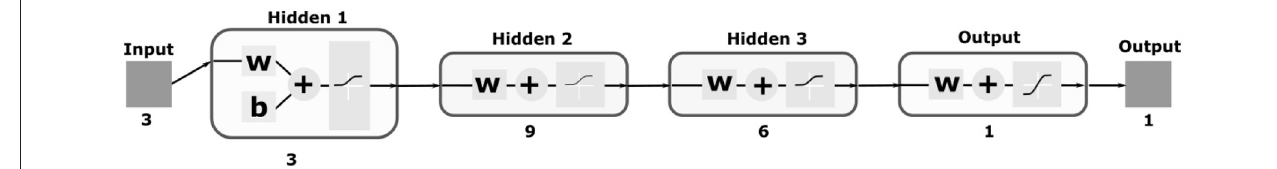
FIGURE 8 | Illustration of the MLP neural network used as part of our DM. The network contains three input neurons which correspond to the properties extracted from cortical neurons; three hidden layers with 3, 9, and 6 neurons, respectively; and one output neuron since we designed the network as a regression model. Log-sigmoid and hyperbolic tangent sigmoid transfer functions were used as presented within the diagrams of the neurons.